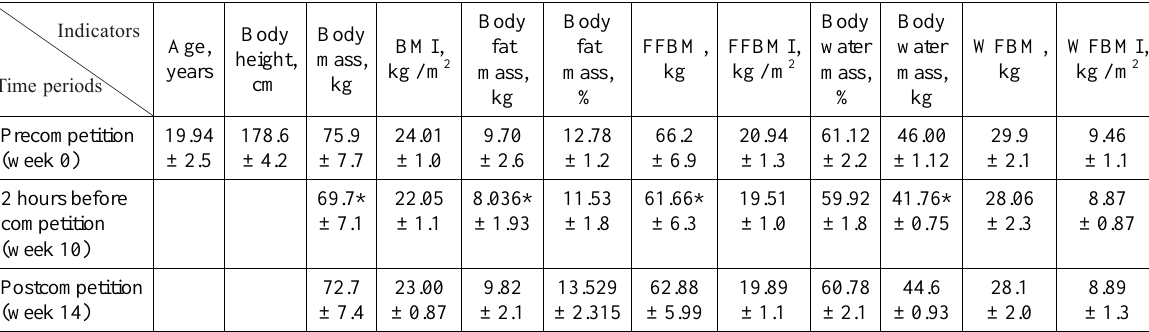
Table. Age and body composition elements of soccer players at precompetition, competition and postcompetition periods of training